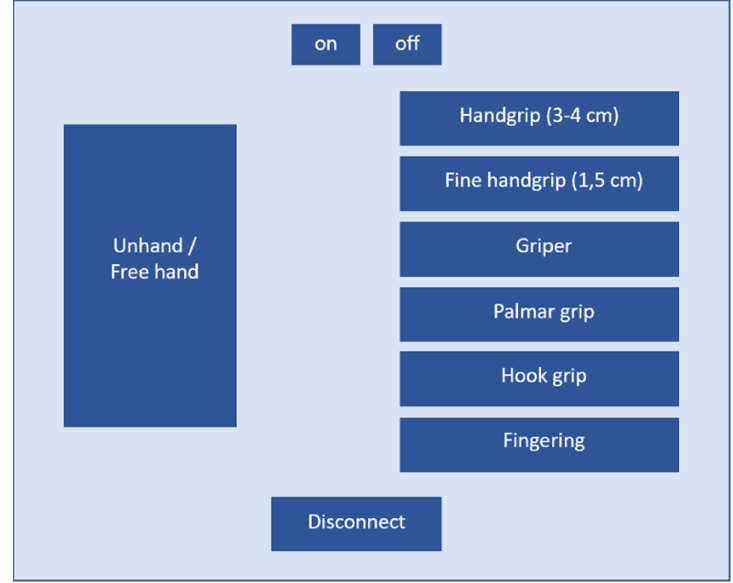
Figure 6. Screenshot of the application.